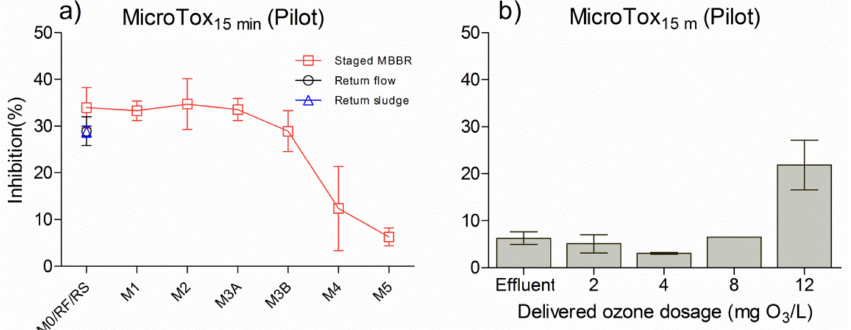
Figure 5. Toxicity measured with the MicroTox ® test with 15 min assay time in a pilot hybrid system ( a ) and onsite continuous pilot ozonation ( b ) M0: municipal influent. RF: return flow from M3B marked with a black circle. RS: return sludge flow from a settling tank after M3B marked with blue triangle. M5: e ffl uent from the pilot system, which was also the initial inlet of ozonation (e ffl uent in Figure 5b).